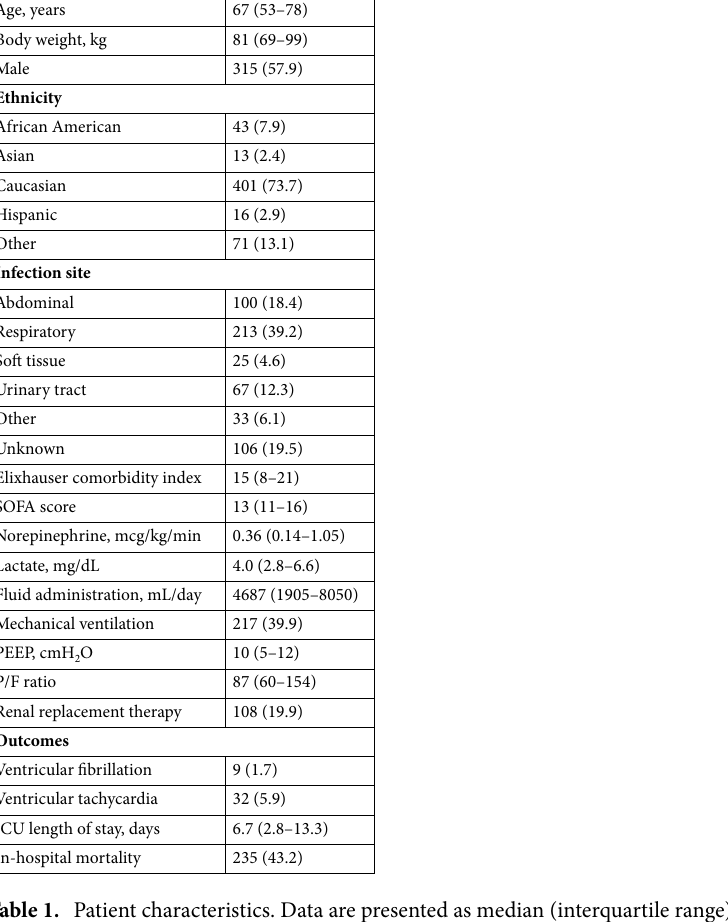
Table 1. Patient characteristics. Data are presented as median (interquartile range) or n (%). ICU intensive care unit, PEEP positive end-expiratory pressure, SOFA Sequential Organ Failure